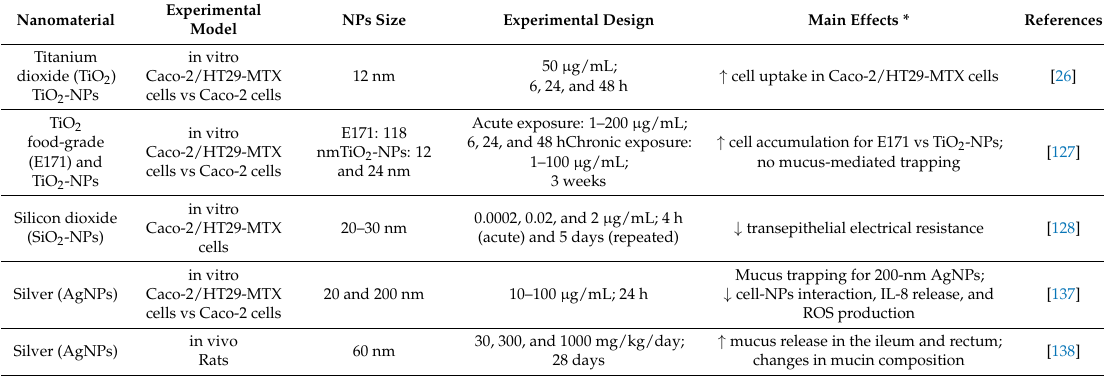
Table 5. Effects of nanomaterials on mucus and mucophilic bacteria in the